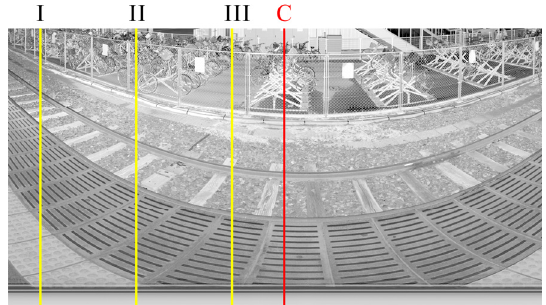
Figure 9. Point data represented in the matrix format